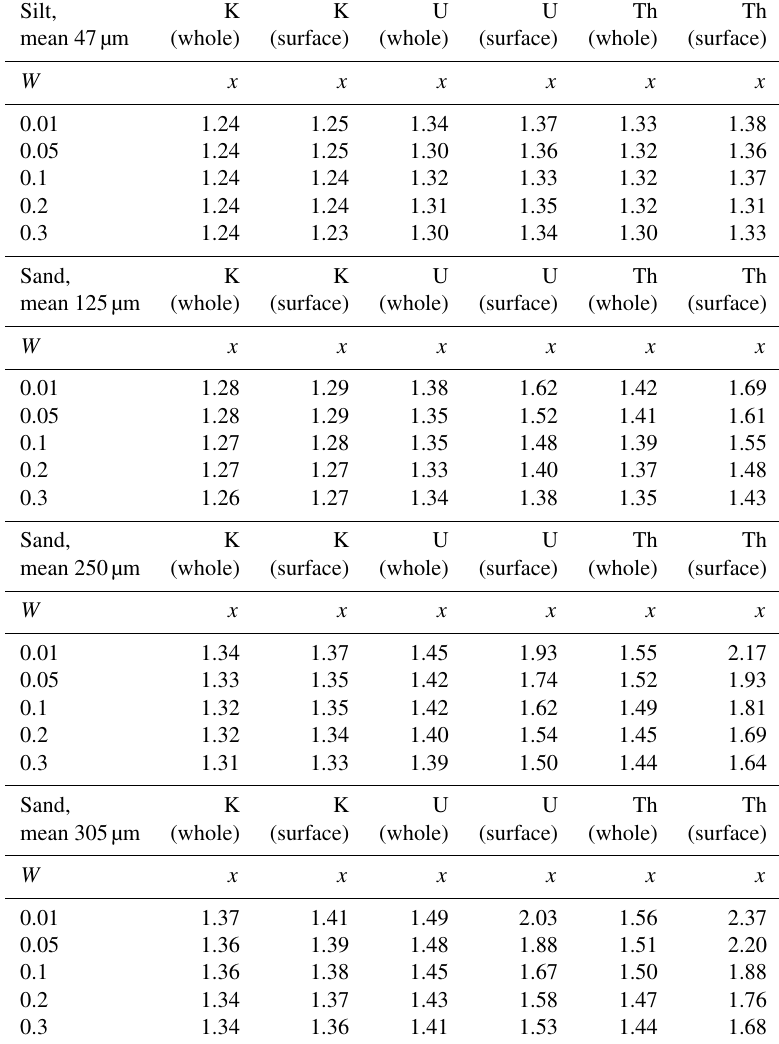
Table 4. Estimates of the water-content parameter x for four well-sorted grain-size distributions. Values depend on the radionuclide source, its location (whole-grain or surface), and on the W (mass of water over dry matrix). Estimated using Monte Carlo simulations with a geometry of packed